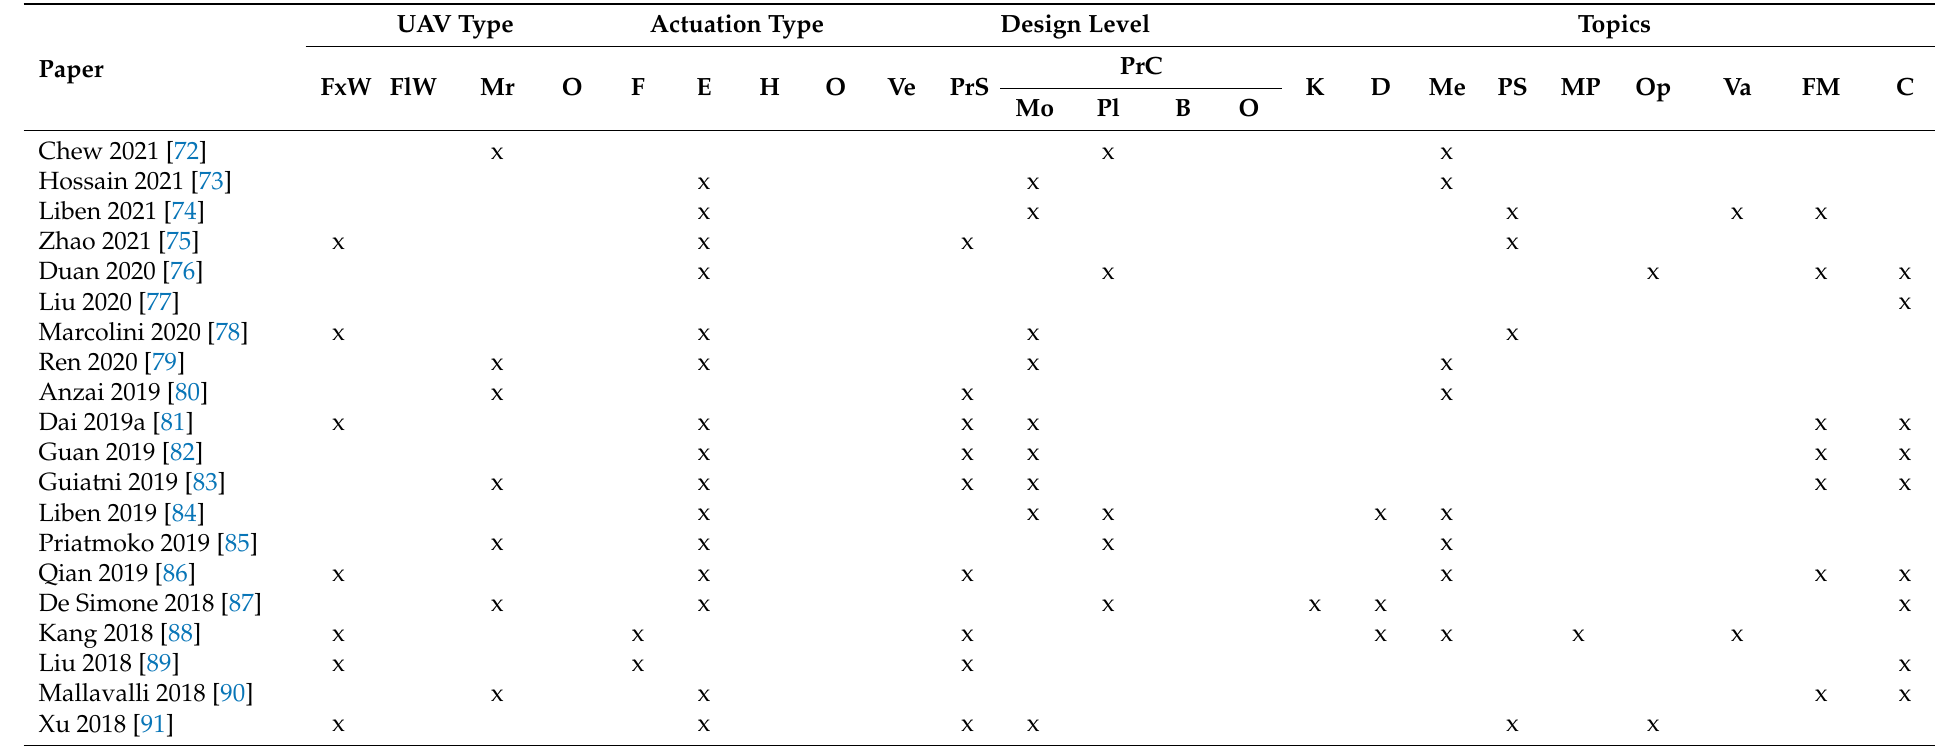
Table 8. Evaluation of the papers categorized in the detailed design category from 2018, according to the taxonomy referring to the paper